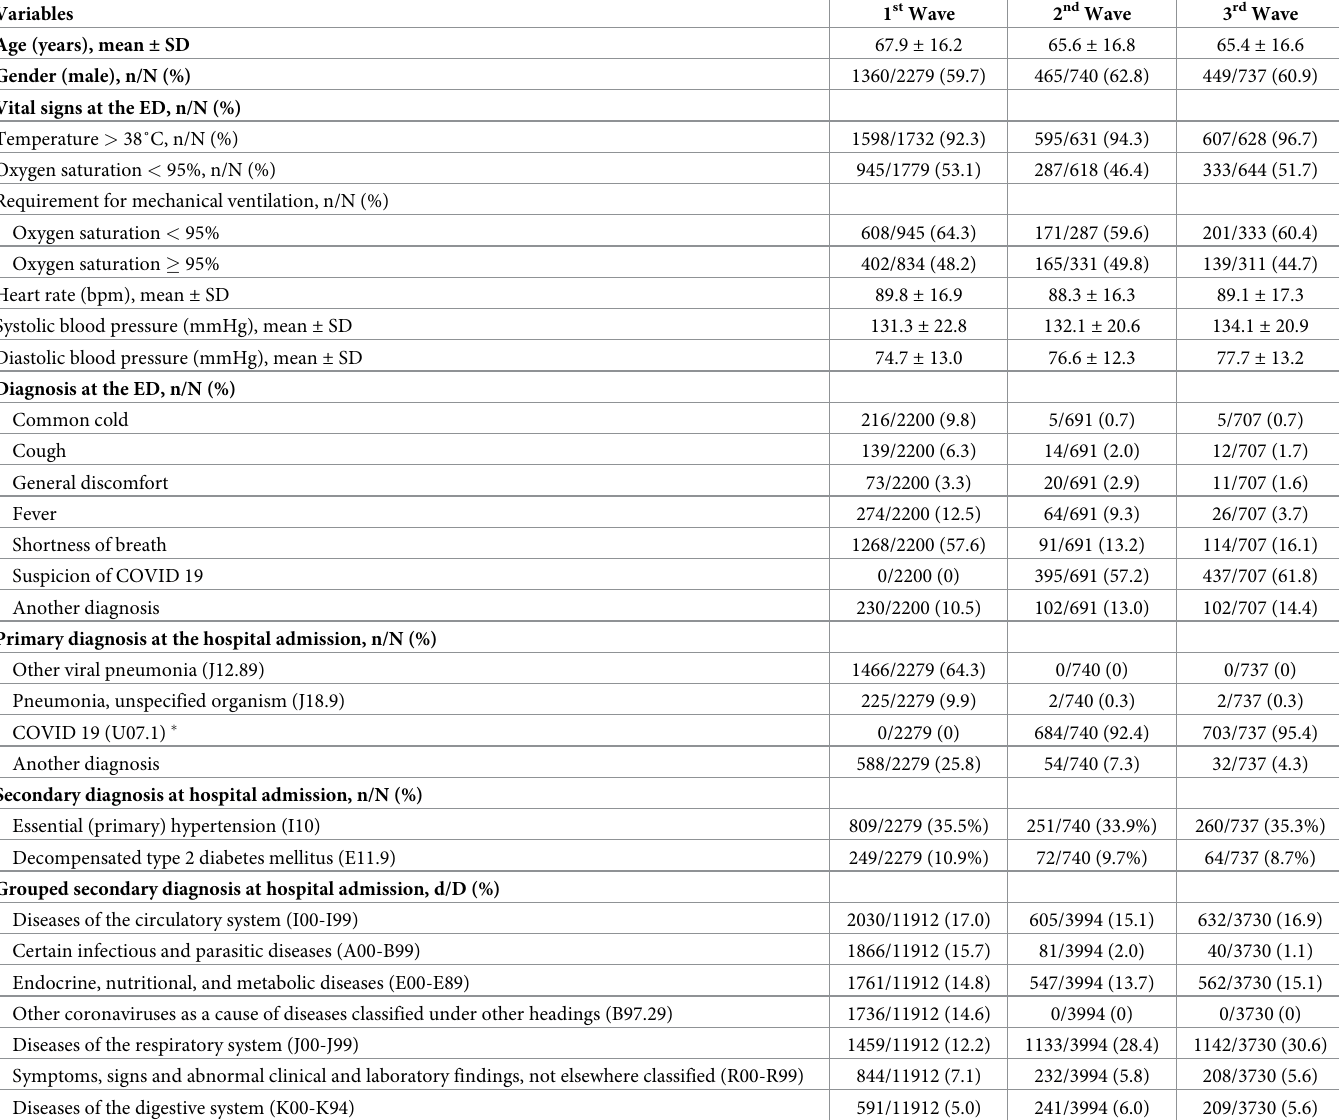
Table 1. Summary of patients’ demographic and clinical parameters at hospital admission (grouped by outbreak